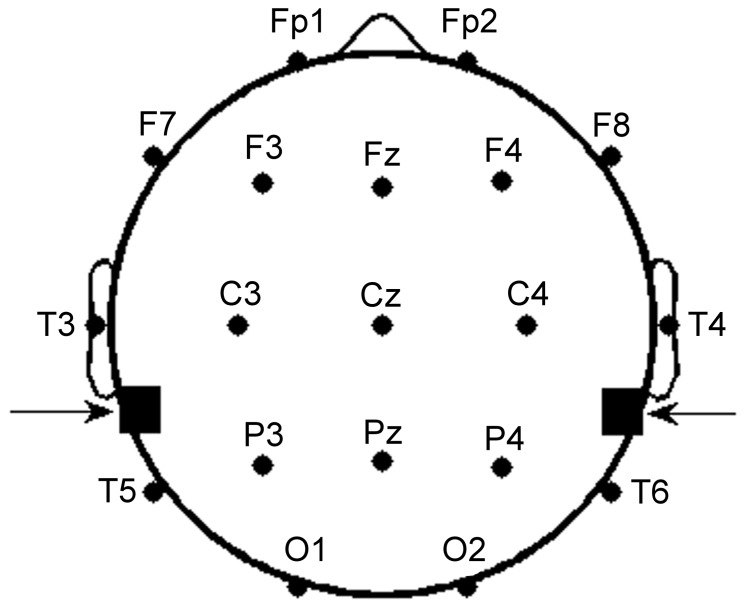
Placement of EEG and stimulating electrodes.19 recording electrodes were placed on the scalp according to the International 10–20 System. Galvanic vestibular stimulation (GVS) electrodes were placed with one electrode on the mastoid process behind each ear (denoted by arrows) for bilateral configuration and transmastoidal stimulation.